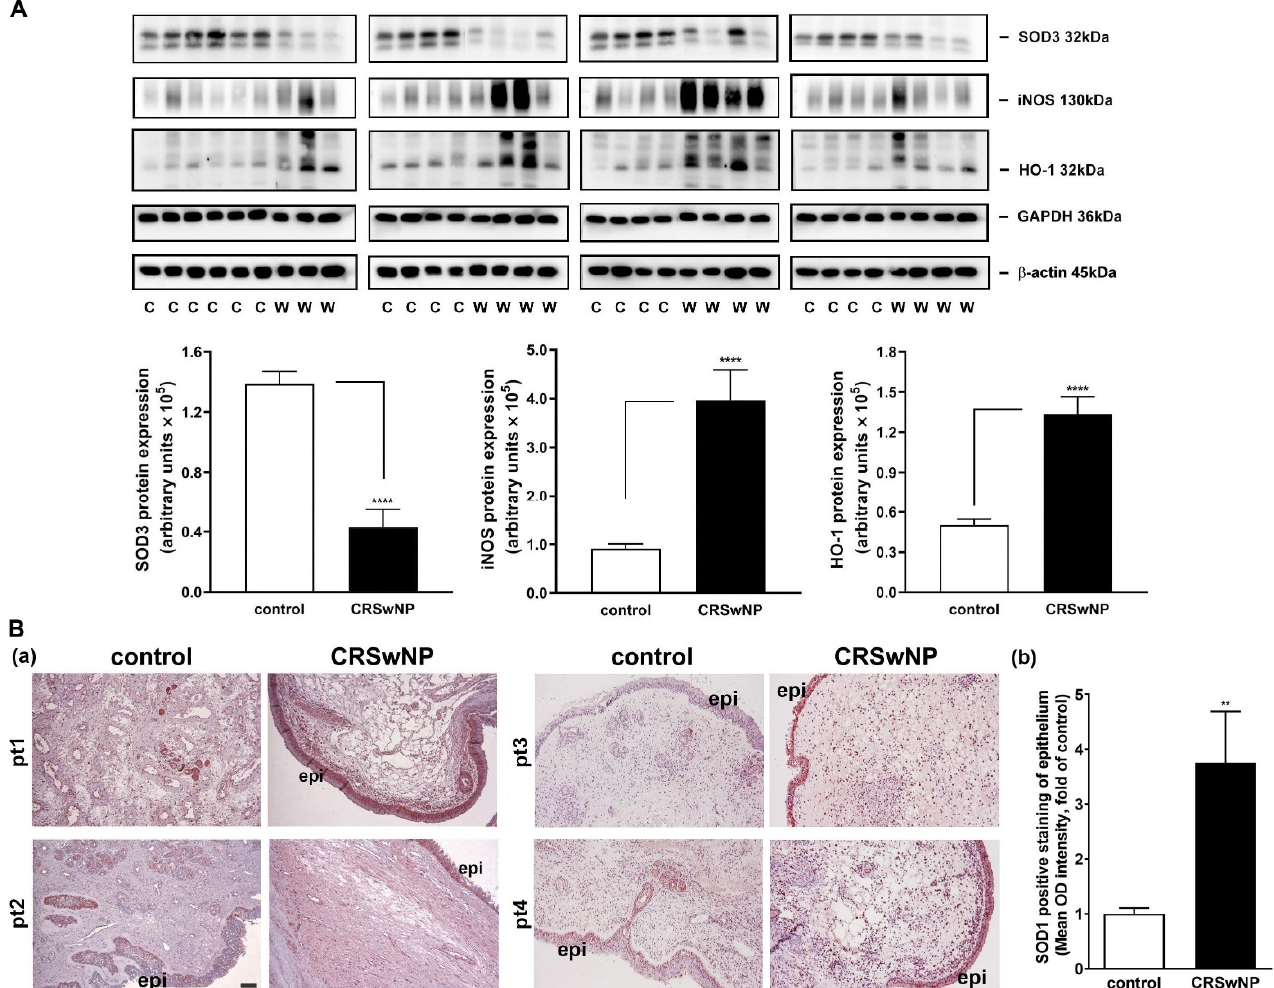
Figure 5. Western blot and IHC analysis of protein expression levels in the representative altered genes in the control nasal mucosae and CRSwNP NPs. ( A ) The protein levels of the representative altered genes in the control nasal mucosae and CRSwNP NPs, including SOD3, iNOS (NOS2), and HO-1, were analyzed in 18 human nasal control mucosae and 15 CRSwNP NP tissues with Western blotting. The iNOS was analyzed with WB in a nonreduced form. A quantitative analysis of the results was performed using densitometry. Data are mean ± SEM. **** p < 0.0001 versus control. ( B ) ( a ) An IHC analysis of SOD1 expression in four representative control nasal mucosae and NP tissues from the control and CRSwNP patients, respectively. Note that the positive staining was mainly found in the epithelium, which is quantified and shown in panel ( b ) ( n = 6). pt: patient; epi: epithelium. Scale bar = 100 μ m. ** p < 0.01 versus control.